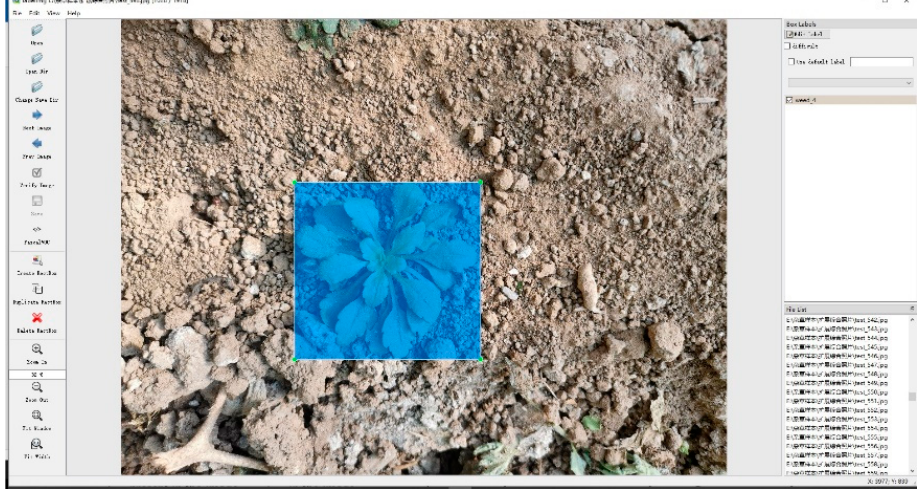
Figure 3. Bounding box annotation of an AP.